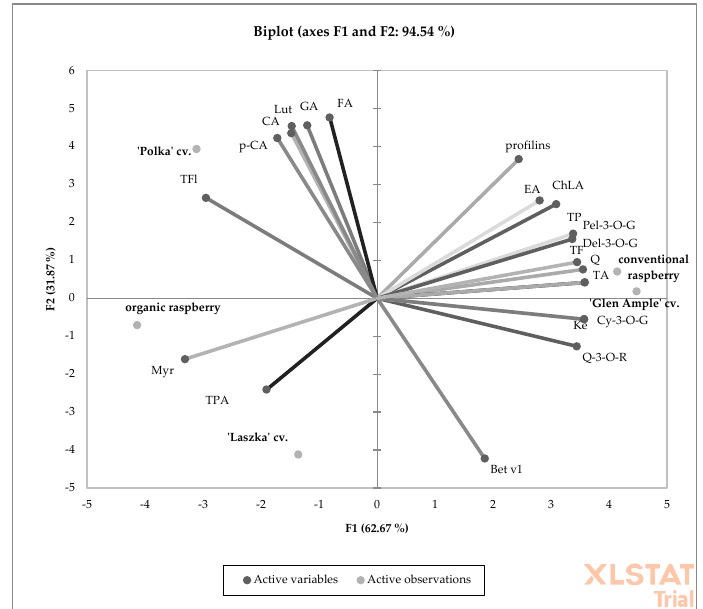
Figure 2. PCA analysis showing the relationship between the chemical composition and allergy potential of organic and conventional raspberry in 2013. (Bet v1) Bet v1; (profilins) profilins; (TP) total polyphenols; (TPA) total phenolic acids; (GA) gallic acid; (ChLA) chlorogenic acid; (CA) caffeic acid; ( p -CA) p -coumaric acid; (FA) ferulic acid; (EA) ellagic acid; (TF) total flavonoids; (TFl) total flavonols; (Q-3-O-R) quercetin-3-O-rutinoside; (Myr) myricetin; (Lut) luteolin; (Q) quercetin; (Ke) kaempferol; (TA) total anthocyanins; (Cy-3-O-G) cyanidin-3-O-glucoside; (Pel-3-O-G) pelargonidoin-3-O-glucoside; (Del-3-O-G)delphinidin-3-O-glucoside.